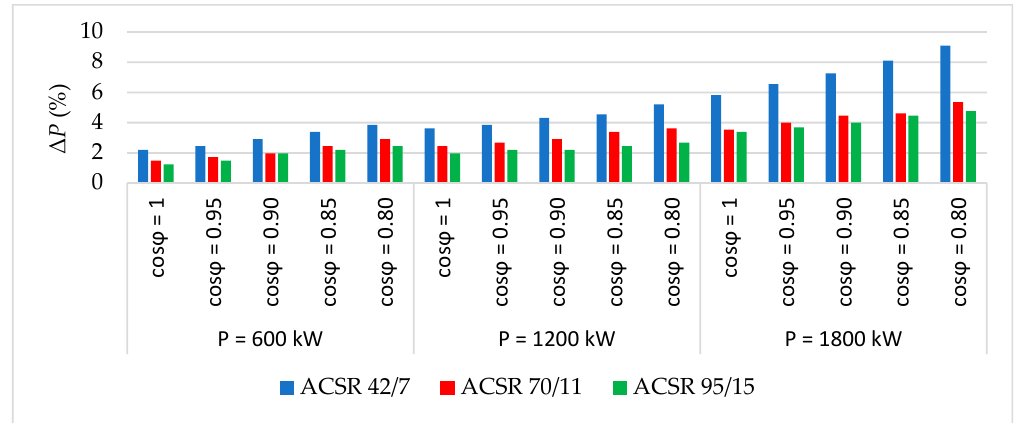
Figure 20. The comparison of the APLs for three types of active power and three types of